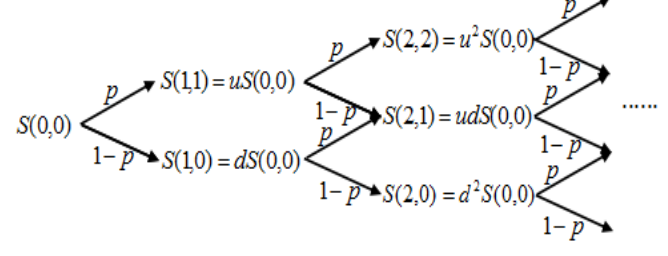
Figure 1. Binary lattice stochastic process of coal price.